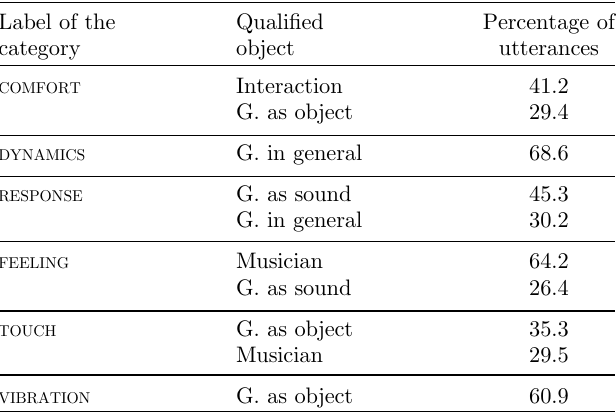
Table 8. Distribution of the quali fi ed object in utterances for each category (quali fi ed object for each category with more than 25% of utterances of the category).